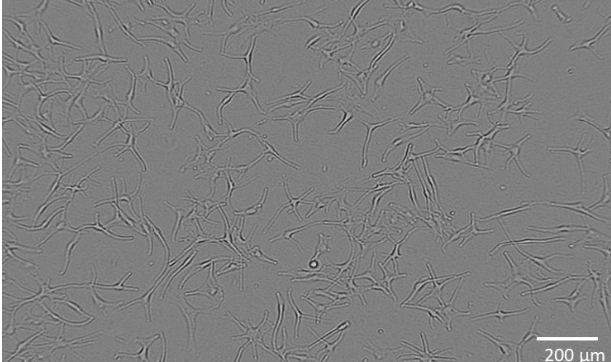
Figure 7. Normal human epidermal melanocytes during cultivation.